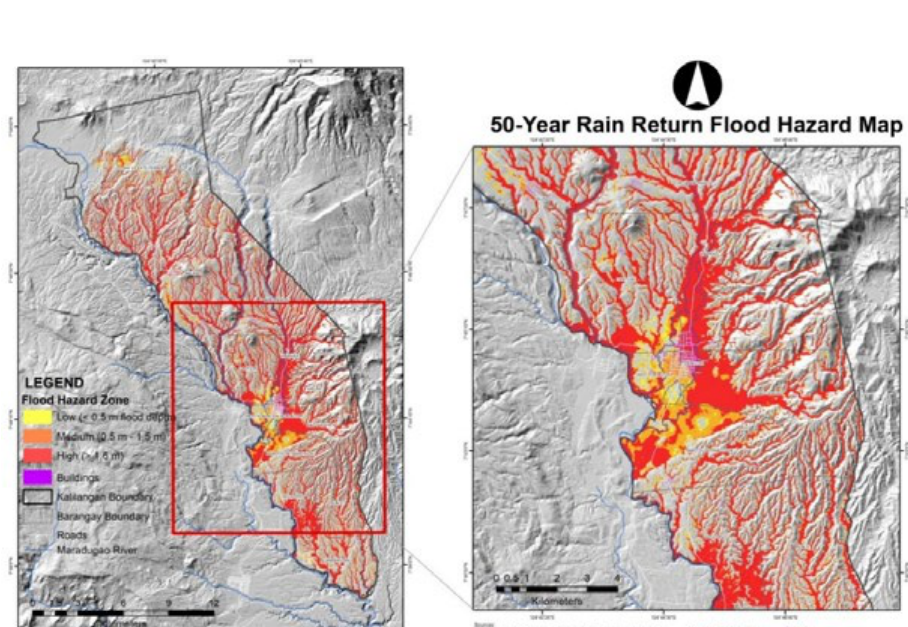
Fig. 7: Flood hazard map of 50-year return period